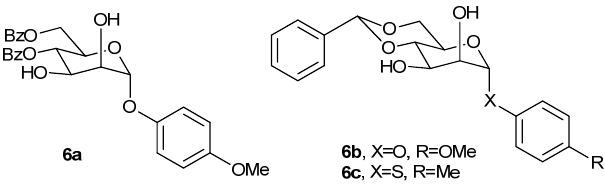
Figure 5. Mannose derived multifunctional low molecular-mass organic gelators (LMOGs).